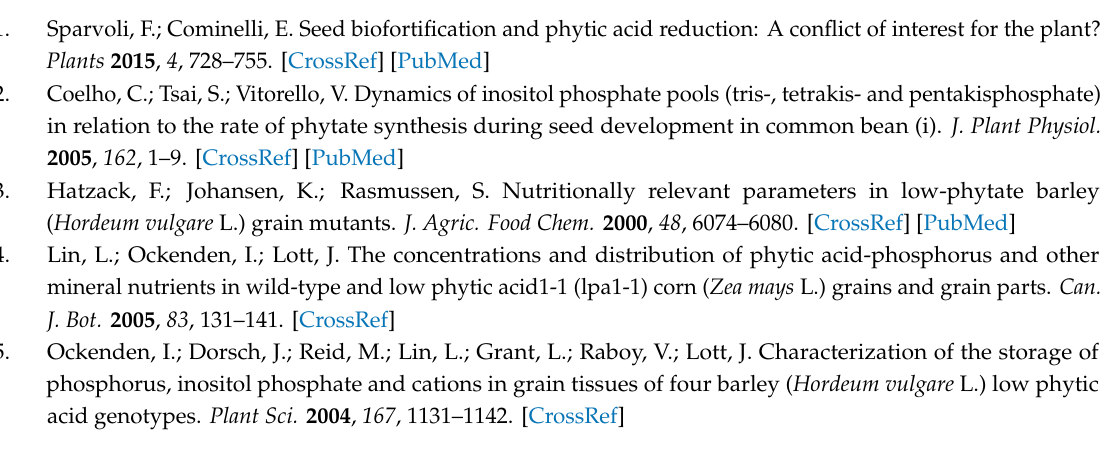
Figure S1. PA-MRP proteins alignment. See Table 1 for the correspondence with genes accession numbers. The Clustal W alignment (cost matrix Blosum, gap open cost 10, gap extend cost 0.1) of Geneious 11.0.2 software was used. Figure S2. Phylogenetic tree of characterized crop PA-MRP proteins, listed in Table 1. Phylogenies were constructed with the Geneious Tree Builder tool, using the Jukes-Cantor distance model, Neighbor-Joining tree build method. Figure S3. Phylogenetic tree of SULTR3;3 and SULTR3;4 proteins, listed in Table 2. Phylogenies were constructed as described in Figure S2. Figure S4. SULTR3;3 proteins alignment. See Tables 1 and 2 for the correspondence with genes accession numbers. The method used is described in Figure S1 legend. Figure S5. SULTR3;4 proteins alignment. See Tables 1 and 2 for the correspondence with genes accession numbers. The method used is described in Figure S1